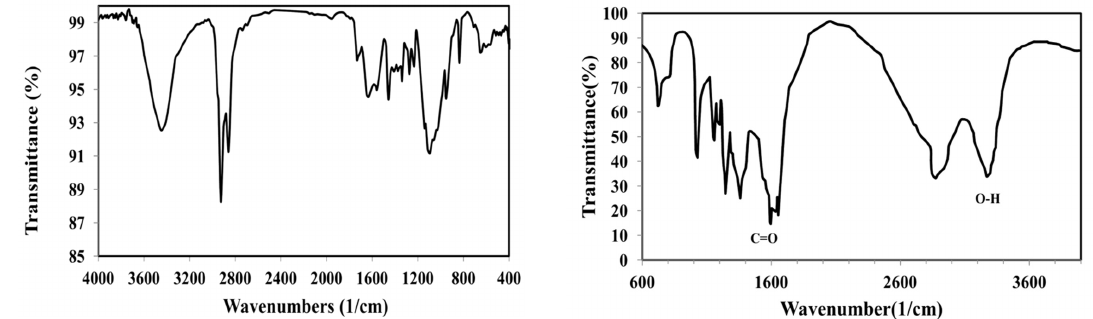
Fig. 6. FTIR spectrum of PEO/CS Fig. 7. FTIR spectrum of PEO/CS/tetracycline